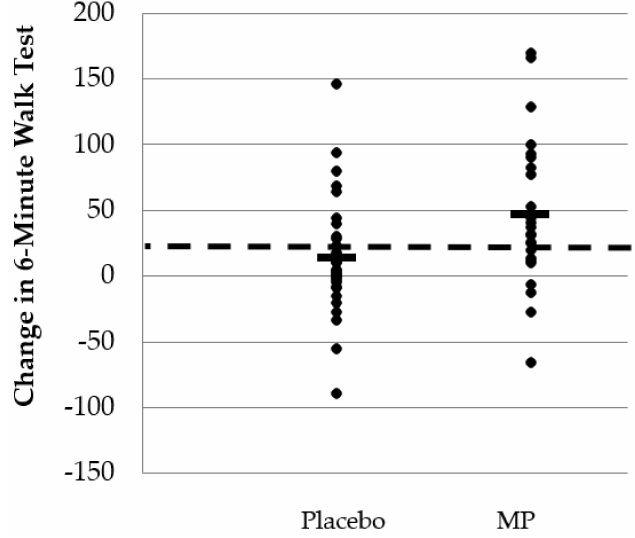
Figure 3. Changes in performance of 6-min walk test after eight weeks of supplementation. The placebo group ( n = 34) reported an average increase in distance covered of 1.39 m. Of the 34 scores in the PLA group, 9 (26.5%) scores experienced a performance improvement greater than the entire study average. The proprietary milk protein concentrate group ( n = 24) reported an average increase in distance covered of 4.74 m. Of the 24 scores in the proprietary milk protein concentrate group, 14 (58.3%) scores experienced a performance improvement greater than the entire study average. Dotted line = average change in 6-min walk distance for entire study cohort. Black horizontal bars = average change in 6-min walk distance for each study group.